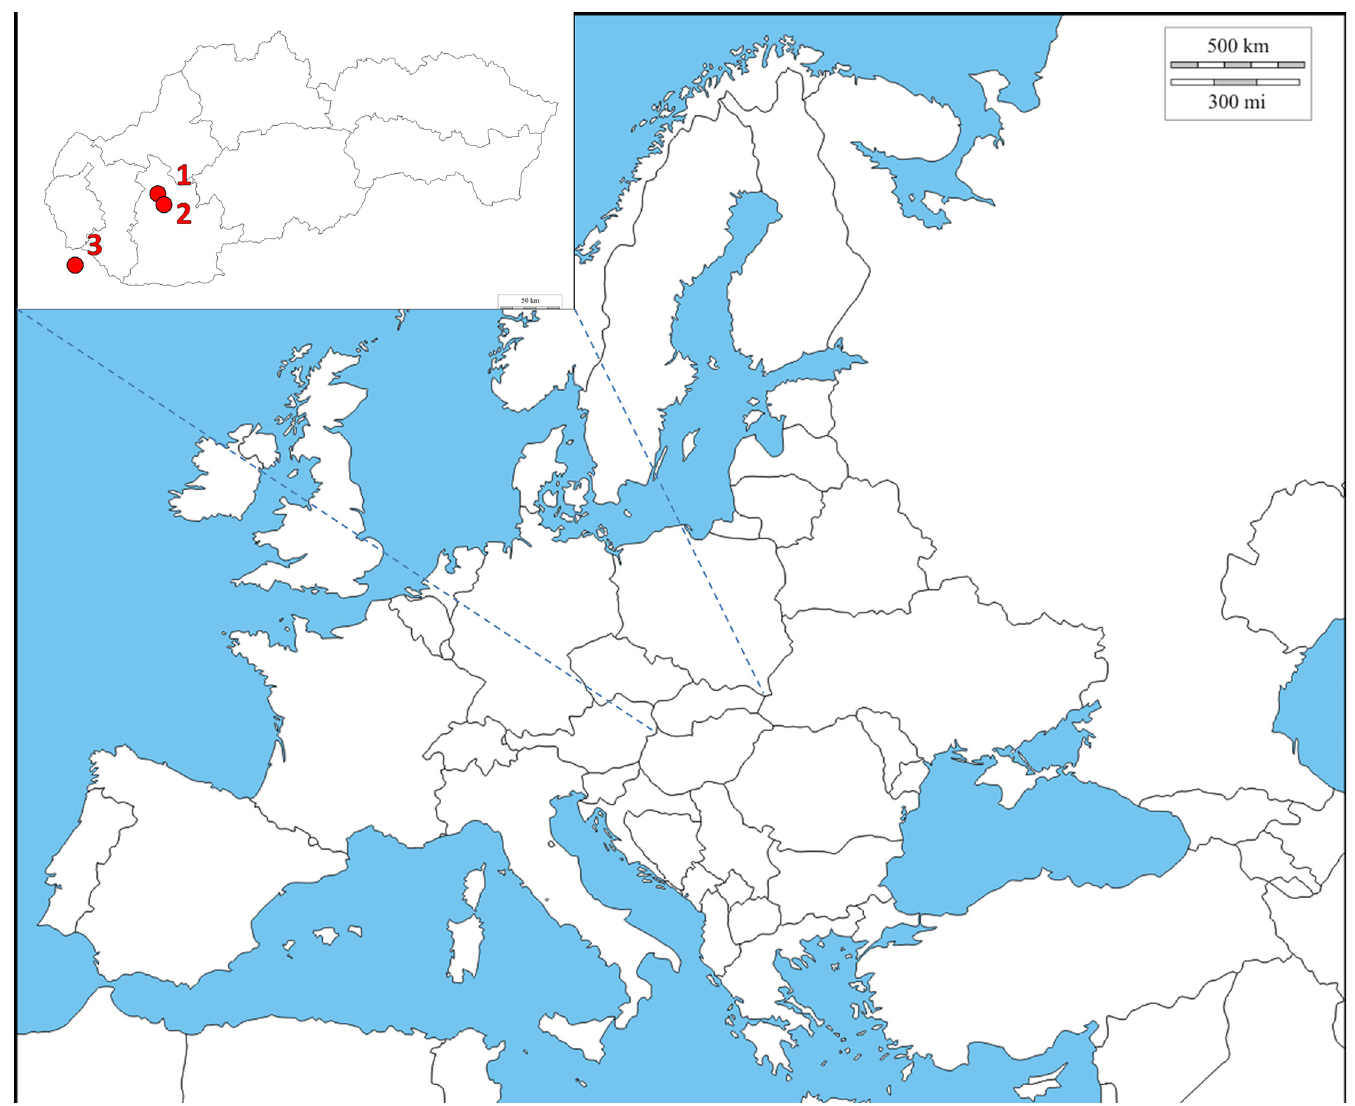
Fig 1. Location of medieval cemeteries from the contact zone of Central Europe. (1) Č akajovce (Slovakia). (2) Nitra- Š indolka (Slovakia). (3) Lébény (Hungary).